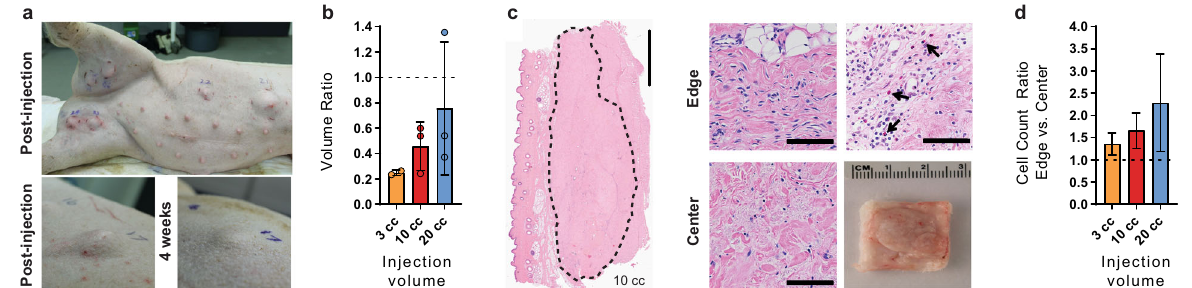
Fig. 5 Allogenic AAT is safe and persistent at large volumes. a Porcine adipose-derived ECM implants injected subcutaneously in Yorkshire cross pigs, imaged immediately post-injection and after 1 month in situ. b Gross image and H&E staining of porcine-derived adipose ECM after 1 month in situ; high magni fi cation images of the edge and center showing cellular in fi ltration, including eosinophils (arrows). c Volume retention ratio after 1 month in situ by initial injection volume. d Cell count ratio between edge and center of porcine implants by initial injection volume. Error bars represent ±1 standard deviation. Scale bars represent 5 mm in whole sections and 100 µm in enlarged regions.